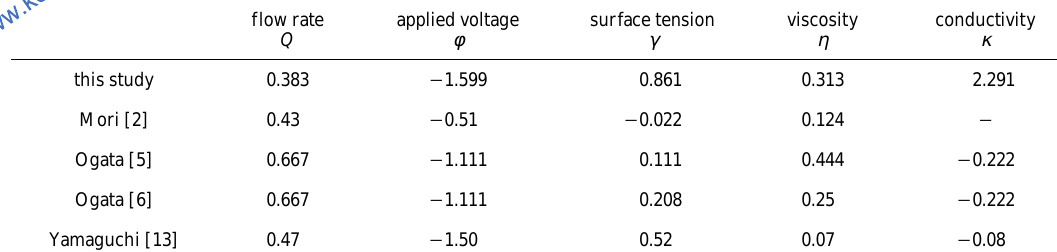
Power indexes of physical properties of sample solution and of operating conditions for the empirical correlation to the size of par- ticles produced by electrostatic atomization. Our results are compared with those of four previous